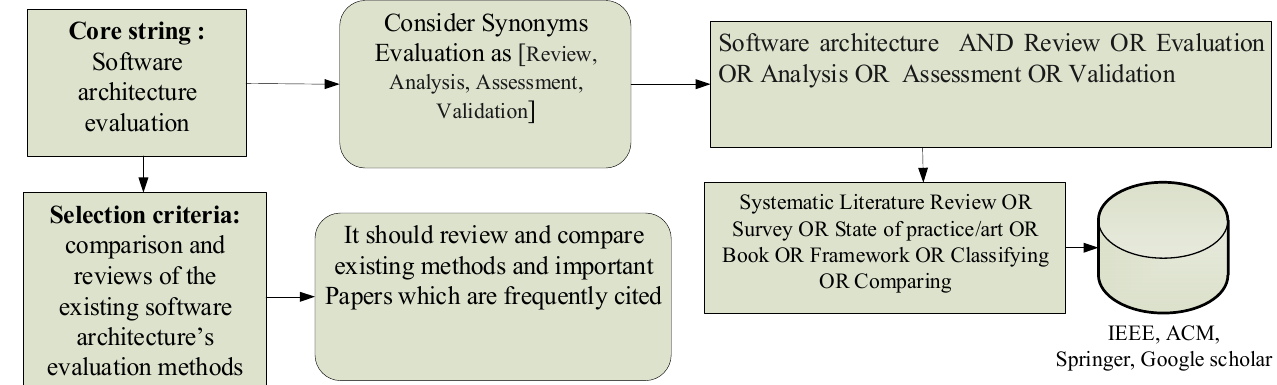
Figure 1. The strategy for selecting credential research and SA evaluation methods.